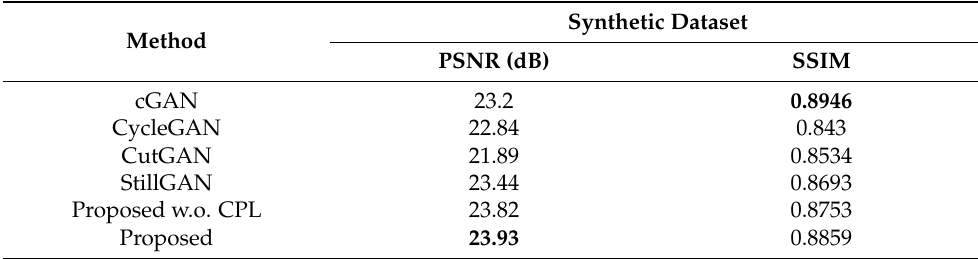
Table 1. Average PSNR (dB) and SSIM results on synthetic dataset, higher score means better performance. The best results are marked in